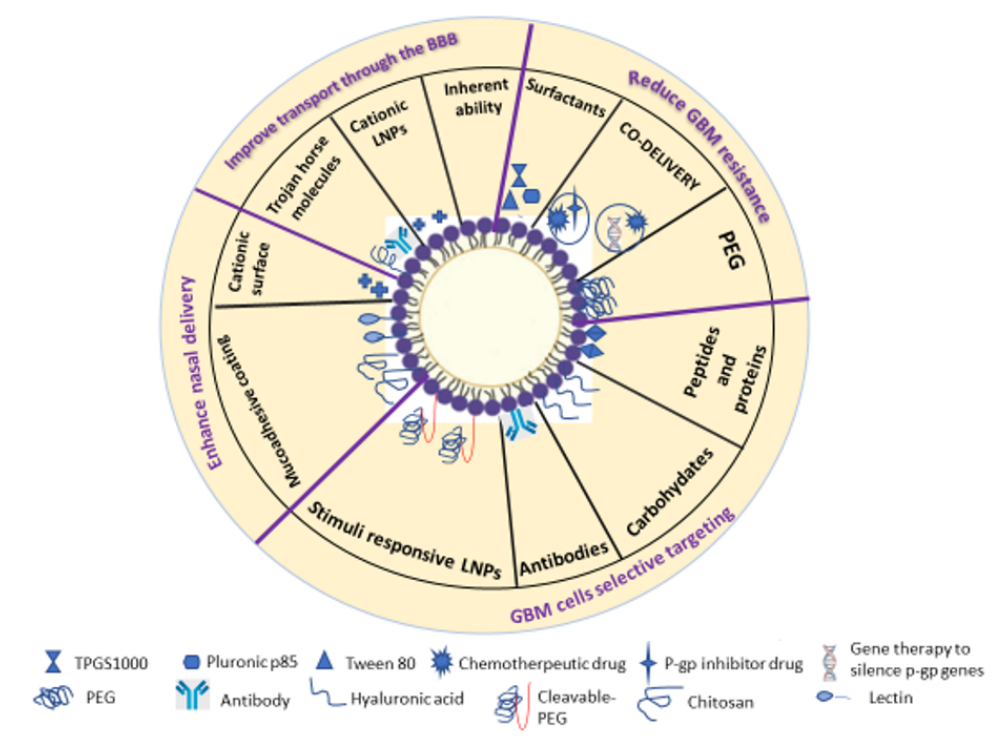
Figure 3. Modification strategies of solid lipid nanoparticles (SLNs) and nanostructured lipid carriers (NLCs) to enhance GBM